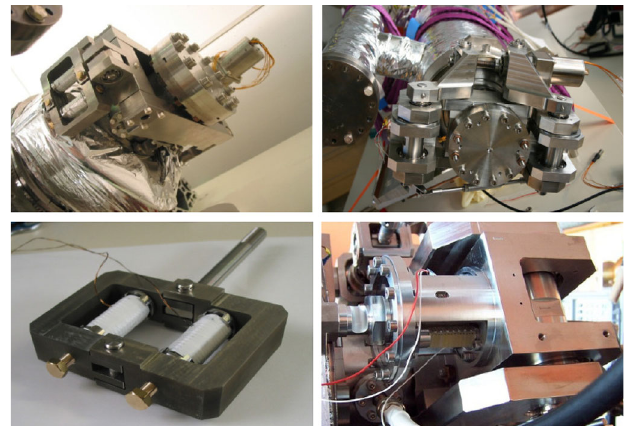
FIG. 9. (Color) Saclay tuning systems for TESLA cavities. The upper row shows pictures of the Saclay I tuner (left) and Saclay II tuner mounted on the cryovessel of a cavity. The lower pictures display the piezo holder frame of the Saclay I tuner with a two piezo design (left) and the two piezo design of the Saclay II tuner housing the piezos inside the cylindrical metal